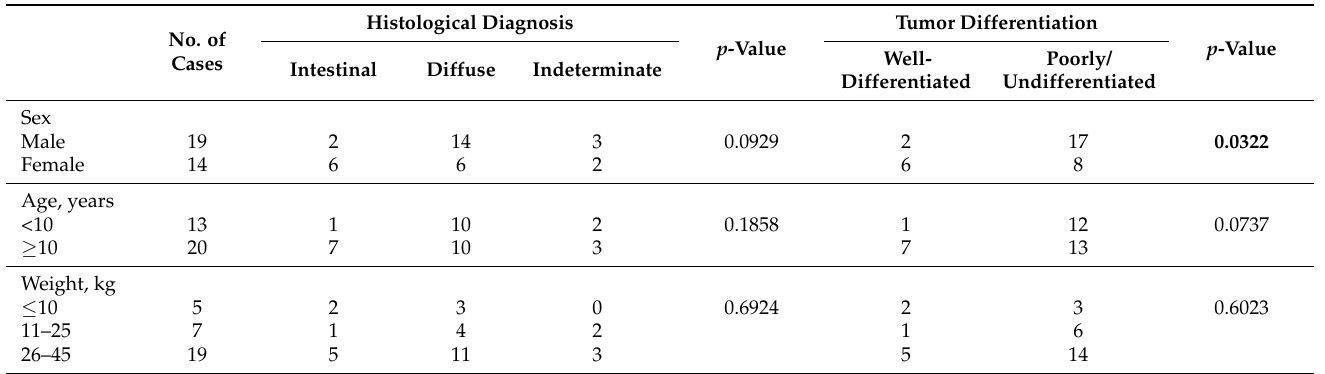
Table 2. Association between histological type according Lauren classification and tumor differen- tiation and sex, age, and weight of the dogs.